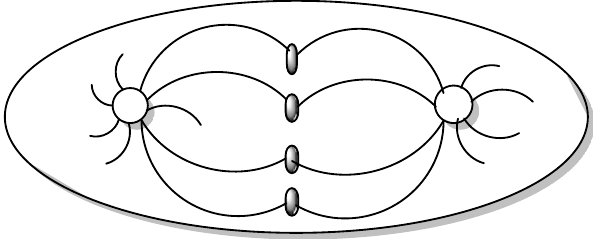
Figure 20. Cell division. In the prometaphase the nuclear envelope breaks down and the chromo- somes condense and microtubules contact chromosomes at the kinetochores. In the early metaphase most chromosome have congressed to the equator. In the anaphase, depicted in Figure 20, the duplicated chromosomes have separated and move toward the spindle pools and the cell divides to form two daughter cells. In the telophase the separated chromosomes have reached the spindle poles and the cells divides into daughter cells [114]. The vinca alkaloids destroy the mitotic spindle and consequently block the mitosis